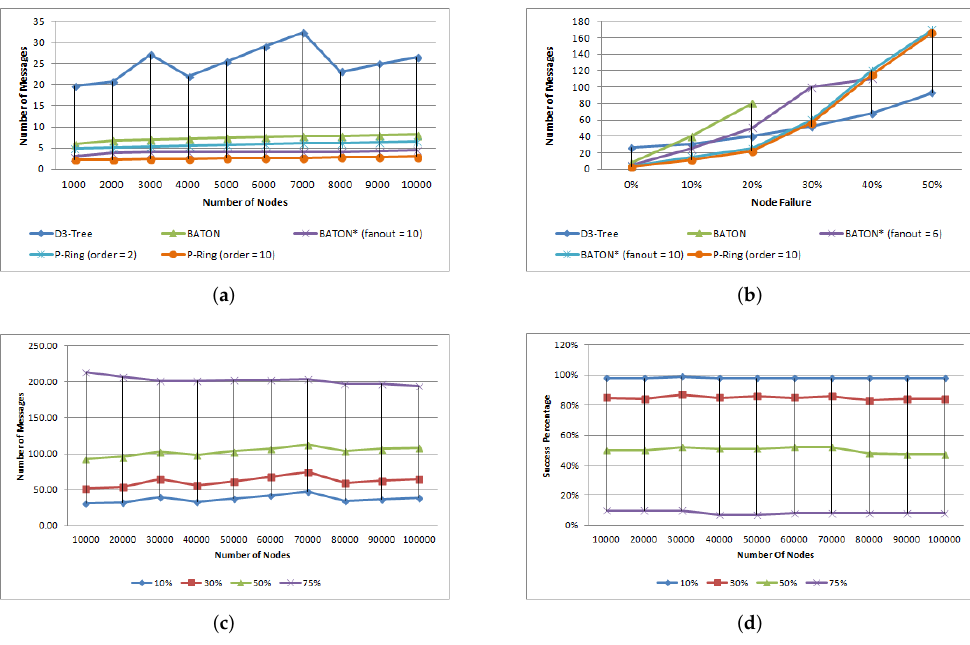
Figure 8. Single queries without/with node failures. ( a ) average messages without failures, ( b ) effect of massive failure, ( c ) average messages of D 3 -Tree, ( d ) success percentage of D 3